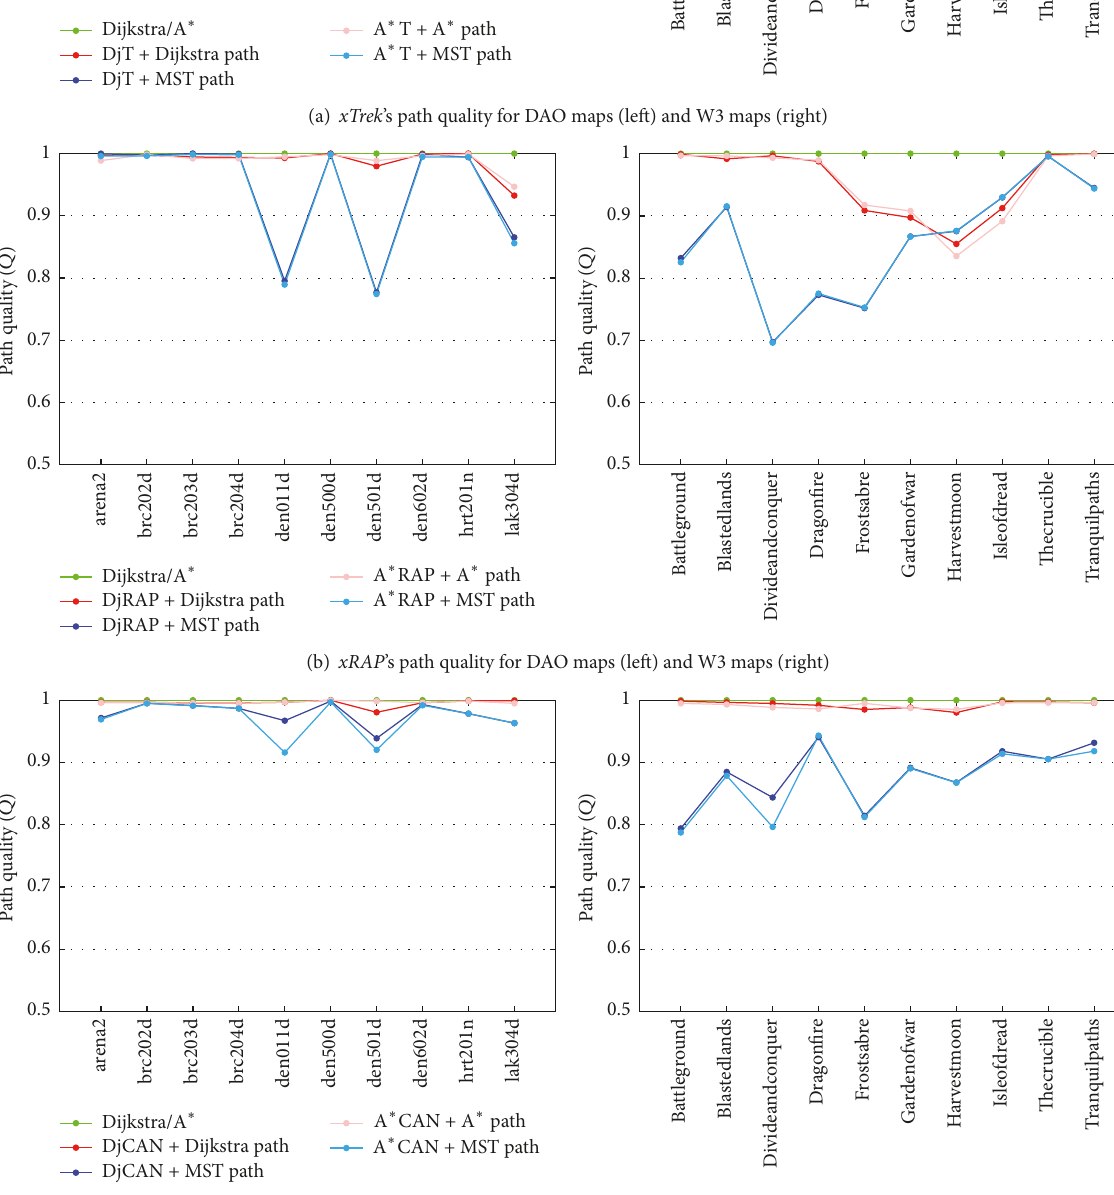
(c) xCAN ’s path quality for DAO maps (left) and W3 maps (right) Figure 15: Path quality ( 𝑄 ) per 12 paths per map for DAO (left-hand side) and W3 (right-hand